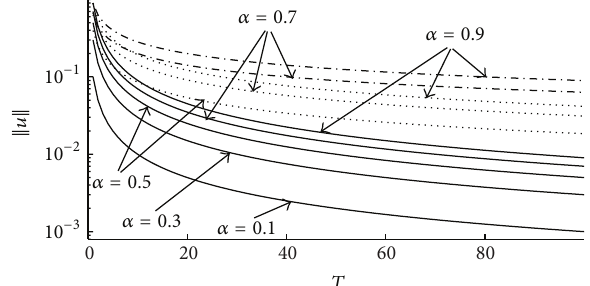
Figure 6: The dependencies for control norm from 𝛼 at 𝑝 󸀠 = 1 and different values of parameter 𝑎 .